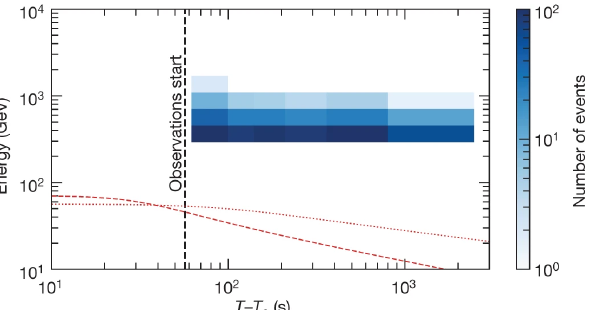
Figure 19. GRB190114C: comparison between the distribution of the observed γ -ray events binned in time and energy (blue shaded areas) and the limiting curves for synchrotron maximum energy. Two different density radial profiles are considered for the derivation of the theoretical curves: constant (red-dotted curve) and wind-like (red-dashed curve). From